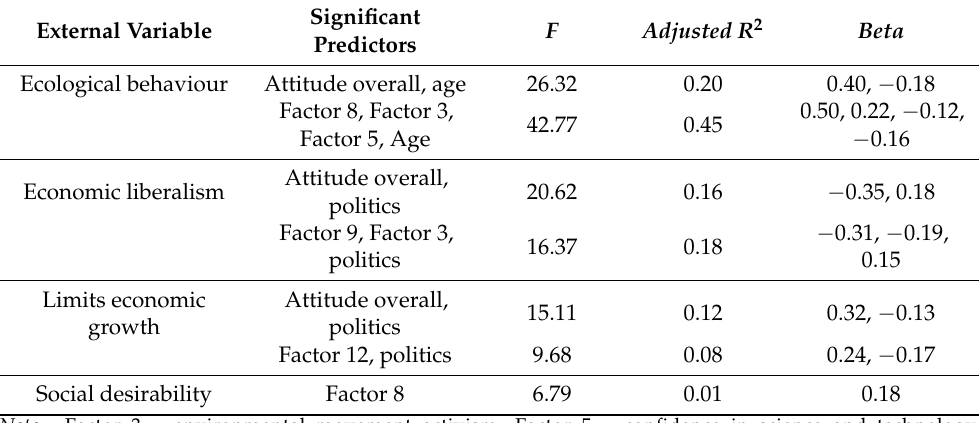
Table 2. Significant regression coefficients of external variables on attitudes in university students ( n = 206). External